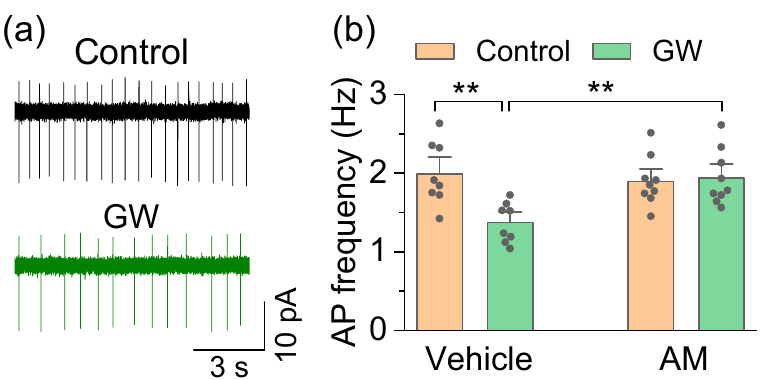
Figure 2. GW842166x (GW) decreased autonomous AP firing in SNc dopamine neurons in drug- naïve mice. ( a ) Bath application of GW (1 µM) decreased AP firing in SNc dopamine neurons. ( b ) Summarized data demonstrating that bath application of GW decreased the frequency of AP firing in SNc dopamine neurons (** p = 0.004, n = 8 cells from 3 mice), and this decrease was blocked by pre-incubation of the slice with AM630 (AM) (** p = 0.008, n = 8–9 cells from 3 mice).